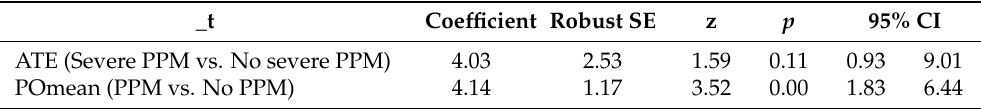
Table 5. Average effect of severe PPM on long-term survival. _t Coefficient Robust SE z p 95% CI ATE (Severe PPM vs. No severe PPM) 4.03 2.53 1.59 0.11 0.93 9.01 POmean (PPM vs. No PPM) 4.14